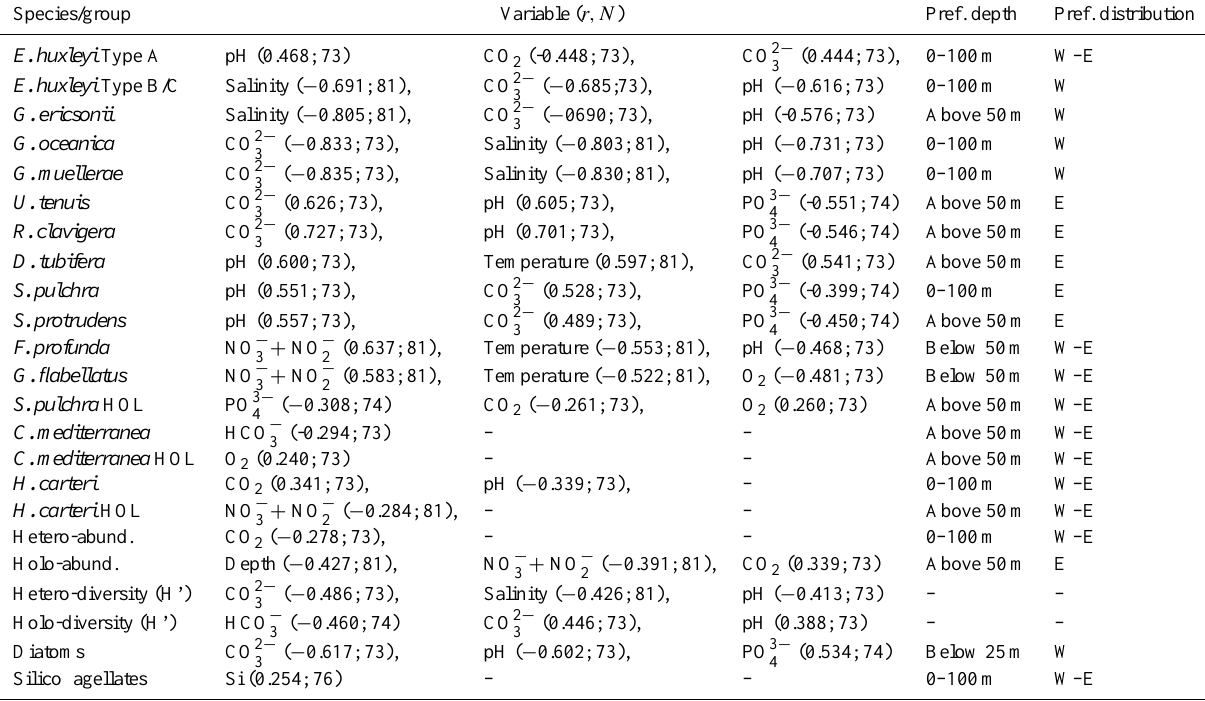
Table 4. Three highest Spearman’s correlation ( ρ ) results for (1) the dominant species Emiliania huxleyi , (2) each of the species belonging to the observed clusters with the environmental parameters, (3) the holo- and hetero-life phases of the same species, and (4) hetero- and holococcolithophore abundances and diversity (H’) and abundances of siliceous phytoplankton groups. Preferential depth and distribution along the west–east transect is described. Number of samples taken into account for the analysis is also shown ( N ). Significance level was